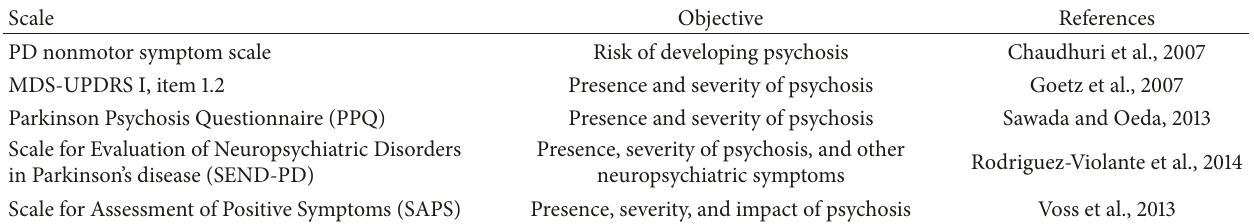
Table 2: Recommended scales for the assessment of psychosis in Parkinson’s